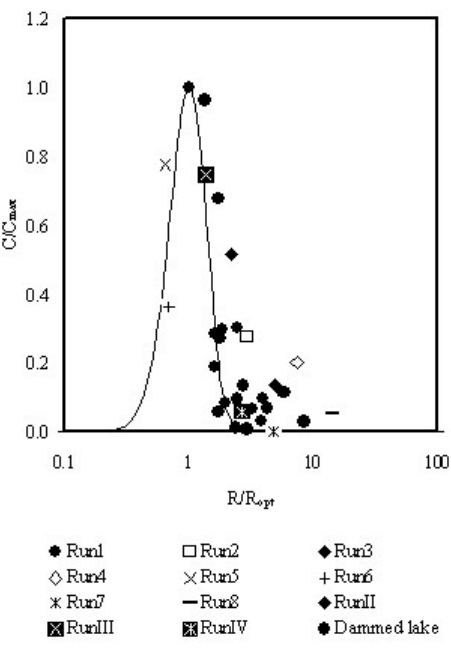
FIGURE 6. Influence of changes in TN:TP ratios by each sediment treatment on Chl.a concentrations. Solid curve represents the estimated distribution of C / C max for dammed lake ( α =